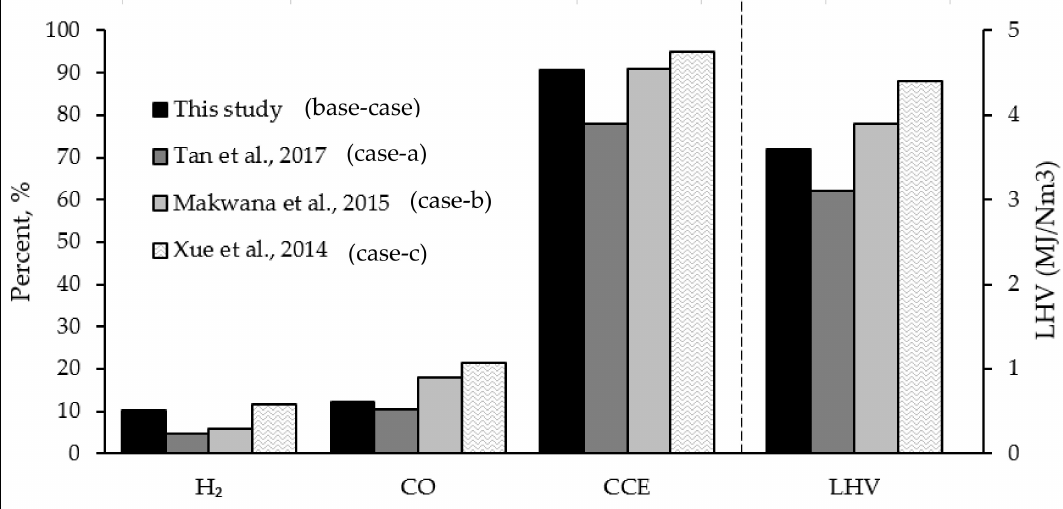
Figure 13. Comparison of results of current study (base case) in terms of syngas composition, CCE and LHV with previous studies conducted by Tan et al. (2017) (case-a) [36], Makwana et al. (2015) (case-b) [8] and Xue et al. (2014) (case-c)